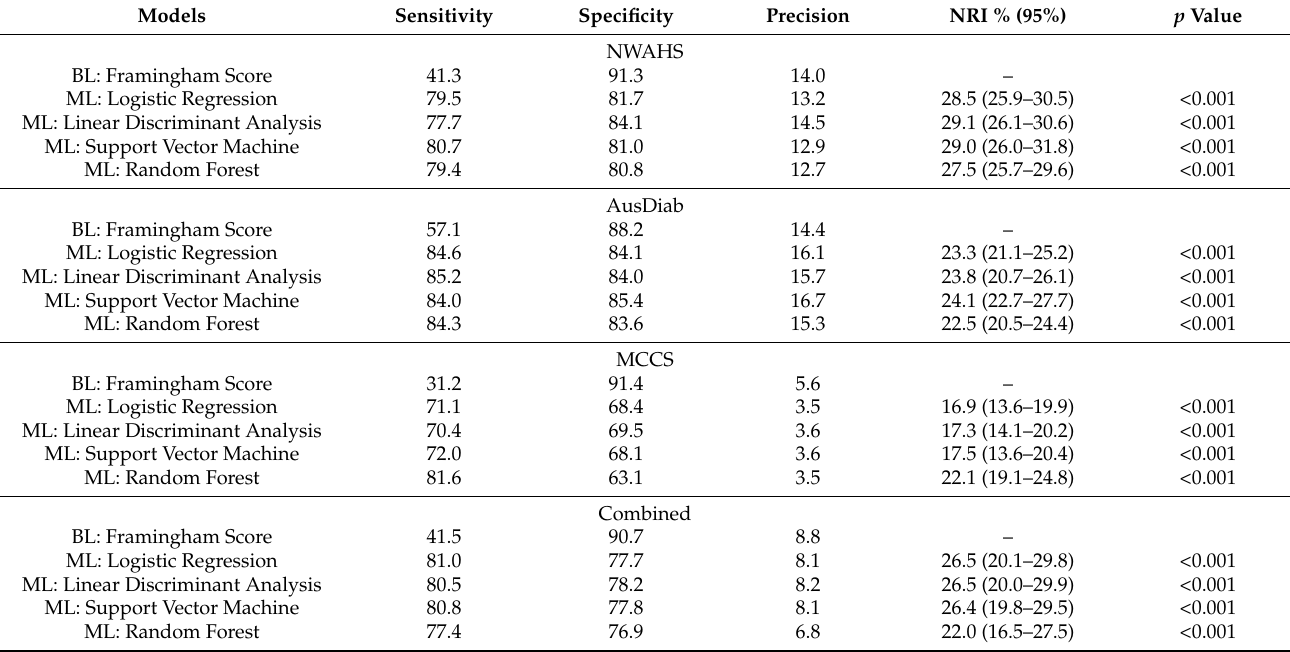
Table 4. Two-fold cross validation: Comparison of classification (Sensitivity, Specificity, Precision) and net reclassification improvement (NRI) performance of Framingham Score (baseline model (BL)) and four machine learning (ML) models predicting 15-year risk of CVD mortality of NWAHS, AusDiab and MCCS participants, and the combined cohort.